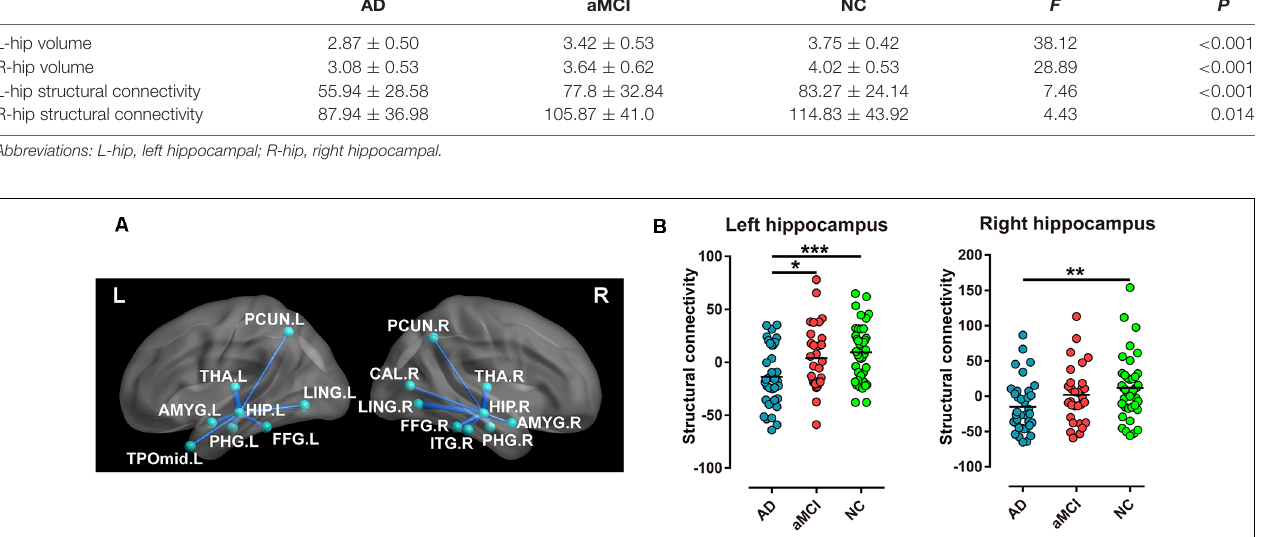
Frontiers in Aging Neuroscience |